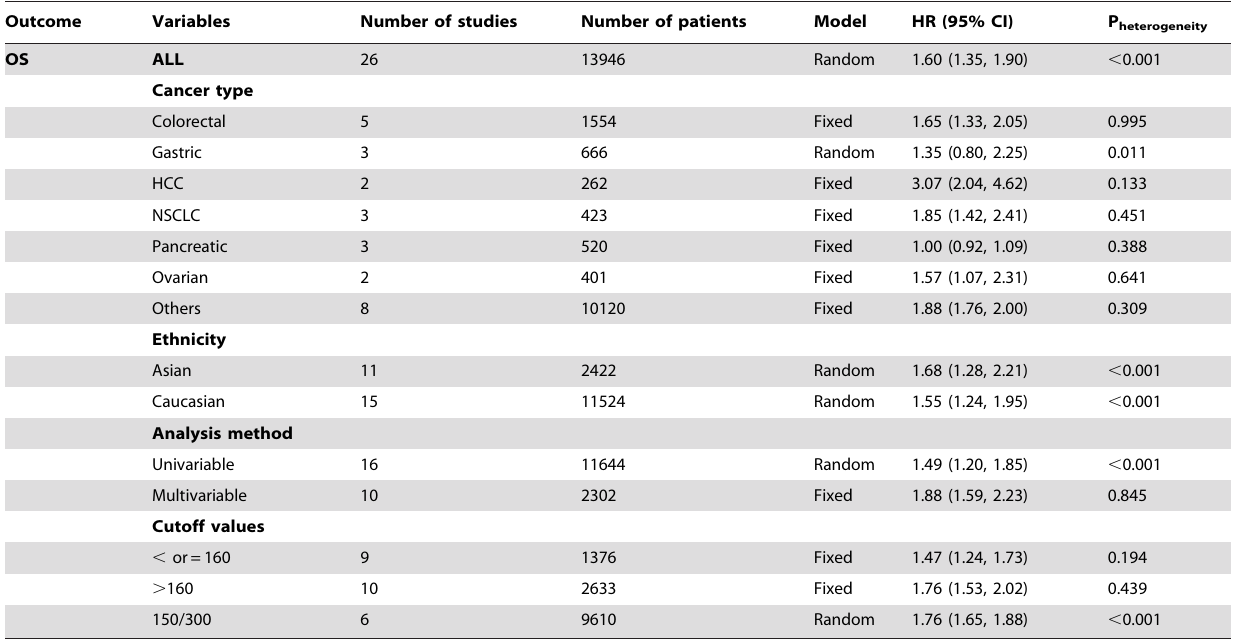
Table 2. Meta-analysis results.